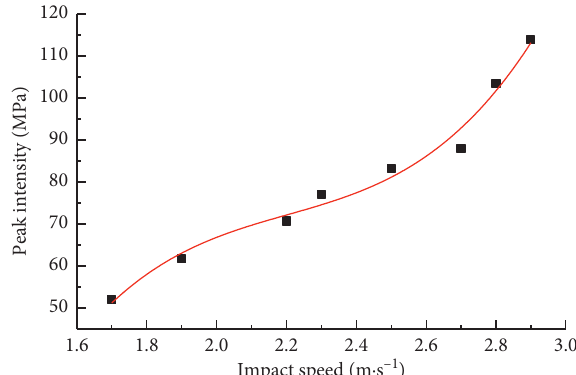
Figure 12: Dynamic elastic modulus changes of saturated lime- stone under different strain